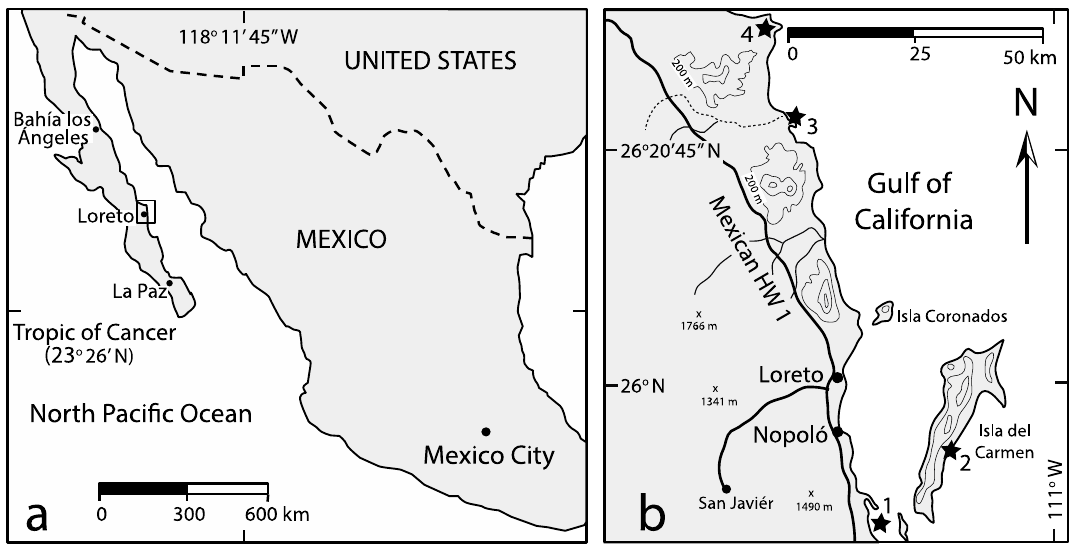
Figure 1. Locality maps showing Mexico’s Baja California peninsula and Gulf of California; ( a ) Mexico and border area with the Unite States, denoting key villages or cities with inset box marking the study region around the town of Loreto; ( b ) Region around Loreto in Baja California Sur, marking coastal boulder deposits (*) at localities 1 to 4.